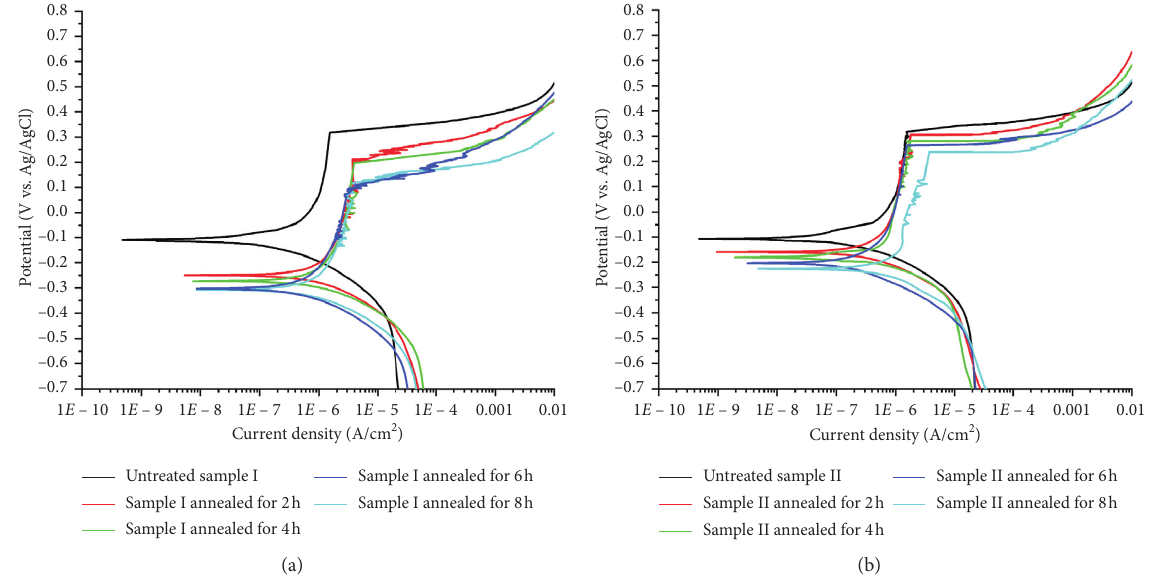
Figure 2: Polarization curves of Sample I (a) and Sample II (b) with different annealing times.